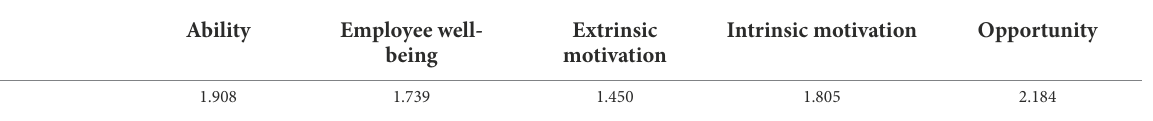
TABLE 2 Full collinearity estimates.